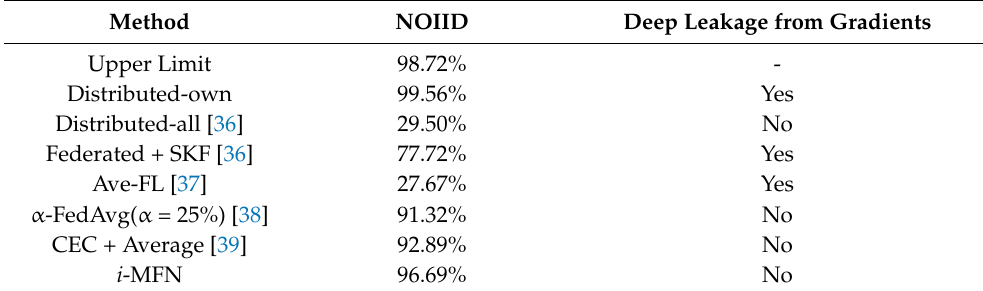
Table 6. Comparison of diagnostic accuracy of different